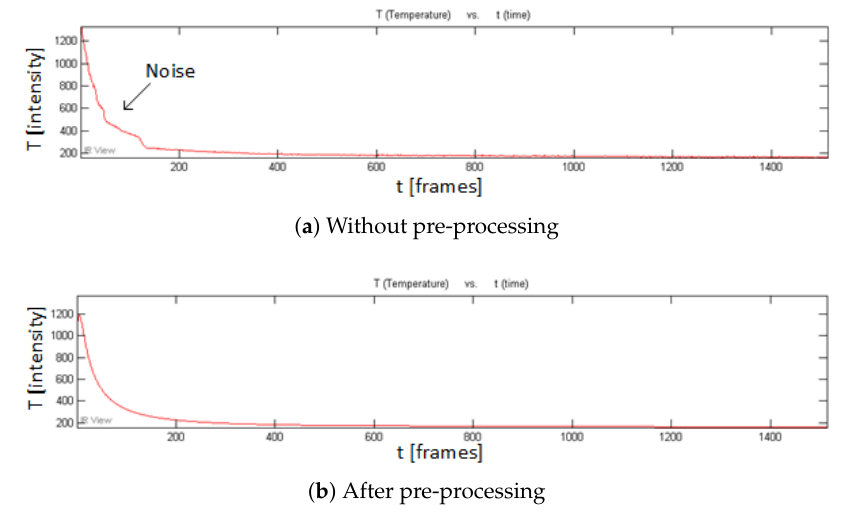
Figure 12. Temperature profile curves (cooling phase) in PT for CFRP